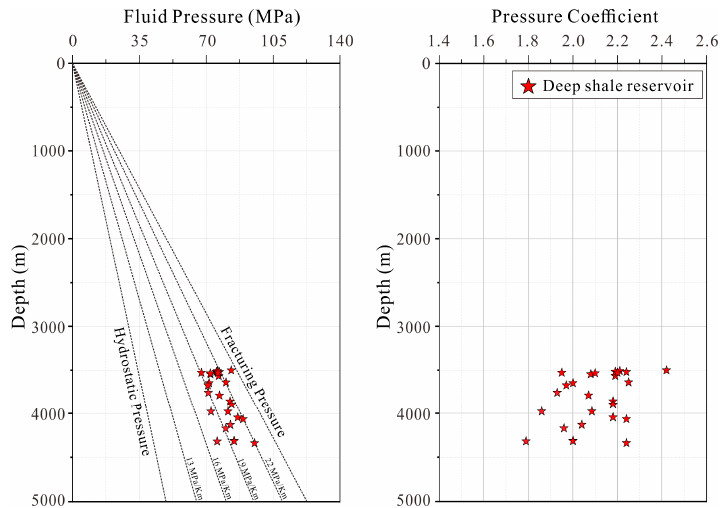
Figure 2. Plots of measured pressure and corresponding pressure coefficient versus depth in the study area show strong overpressure development in deep shale reservoirs.